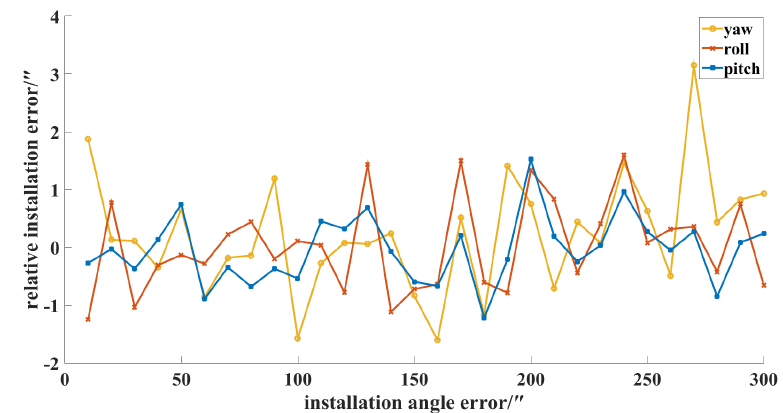
Figure 8. The relative installation errors under different installation angle